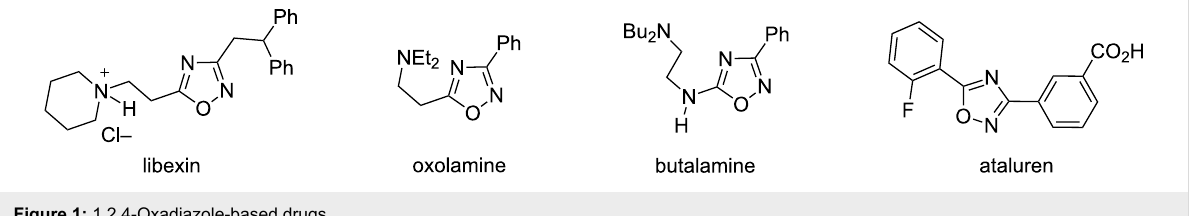
Figure 1: 1,2,4-Oxadiazole-based drugs.